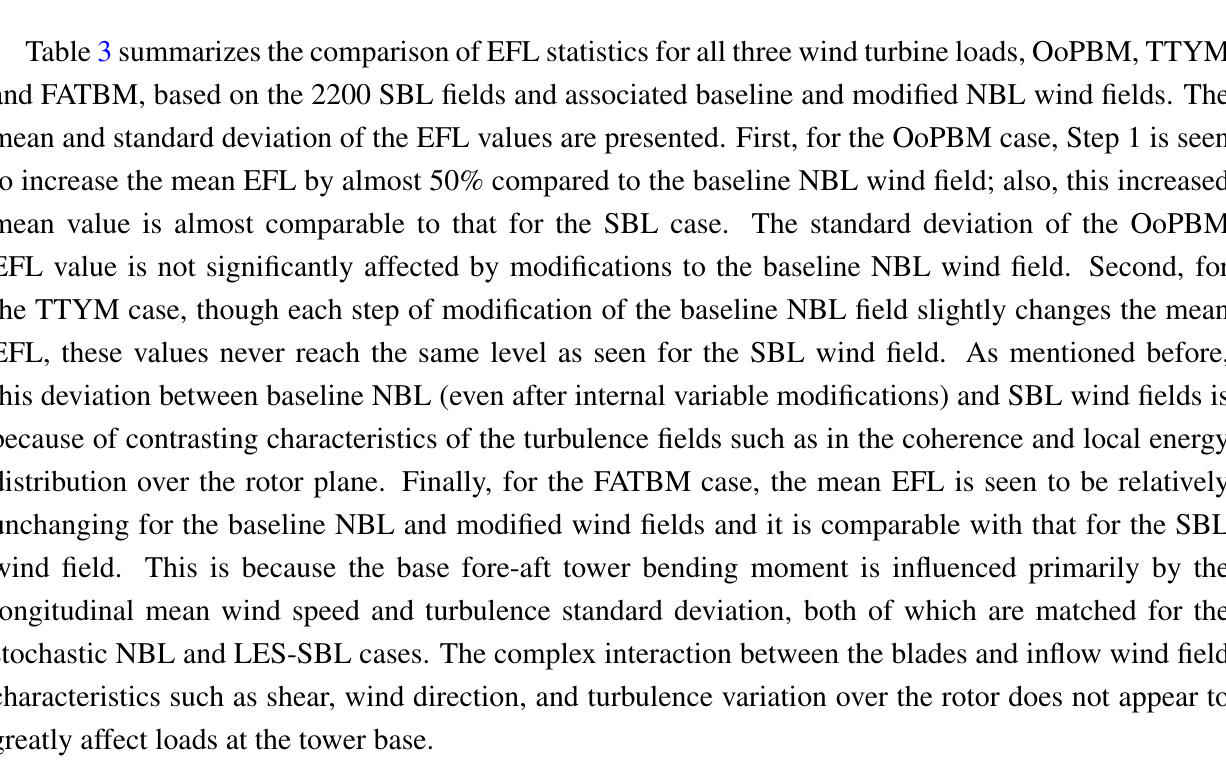
Table 3. EFL statistics from 2200 wind fields (SBL versus baseline NBL and modified